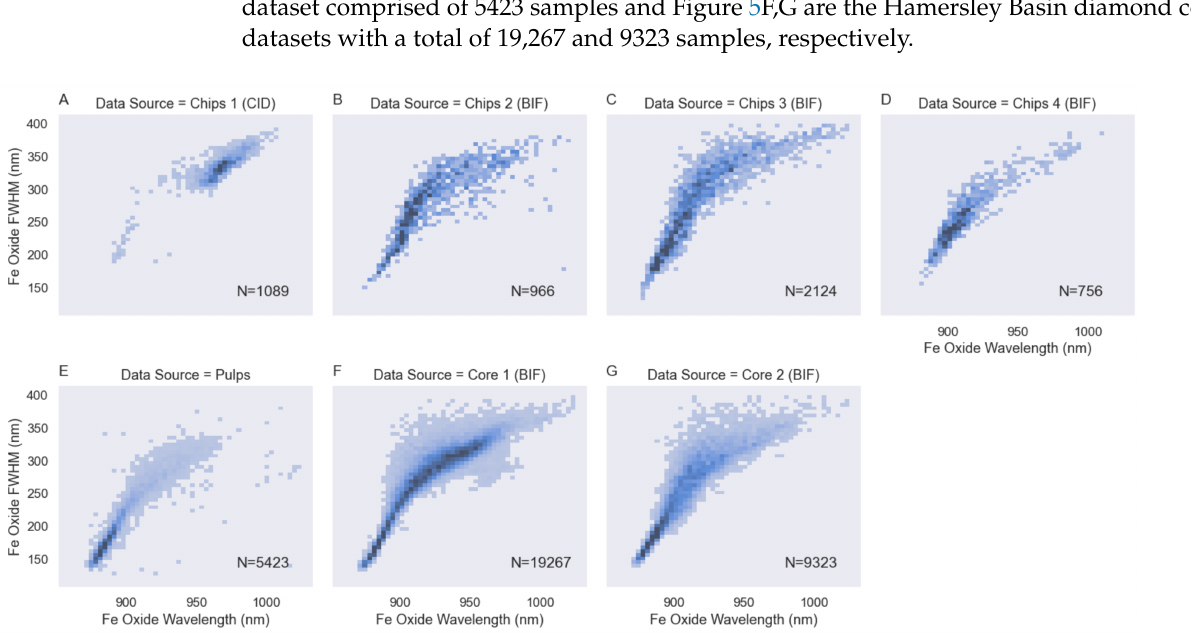
Figure 5. ( A ) is the Rocklea Dome CID RC chips set, ( B – D ) are for the Hamersley Basin BIF RC chip sets, ( E ) is the Hamersley Basin BIF pulp dataset and ( F , G ) are the Hamersley Basin diamond core datasets. ( A ) is primarily goethite and very little hematite. ( D ) is composed of a greater proportion of hematite with some